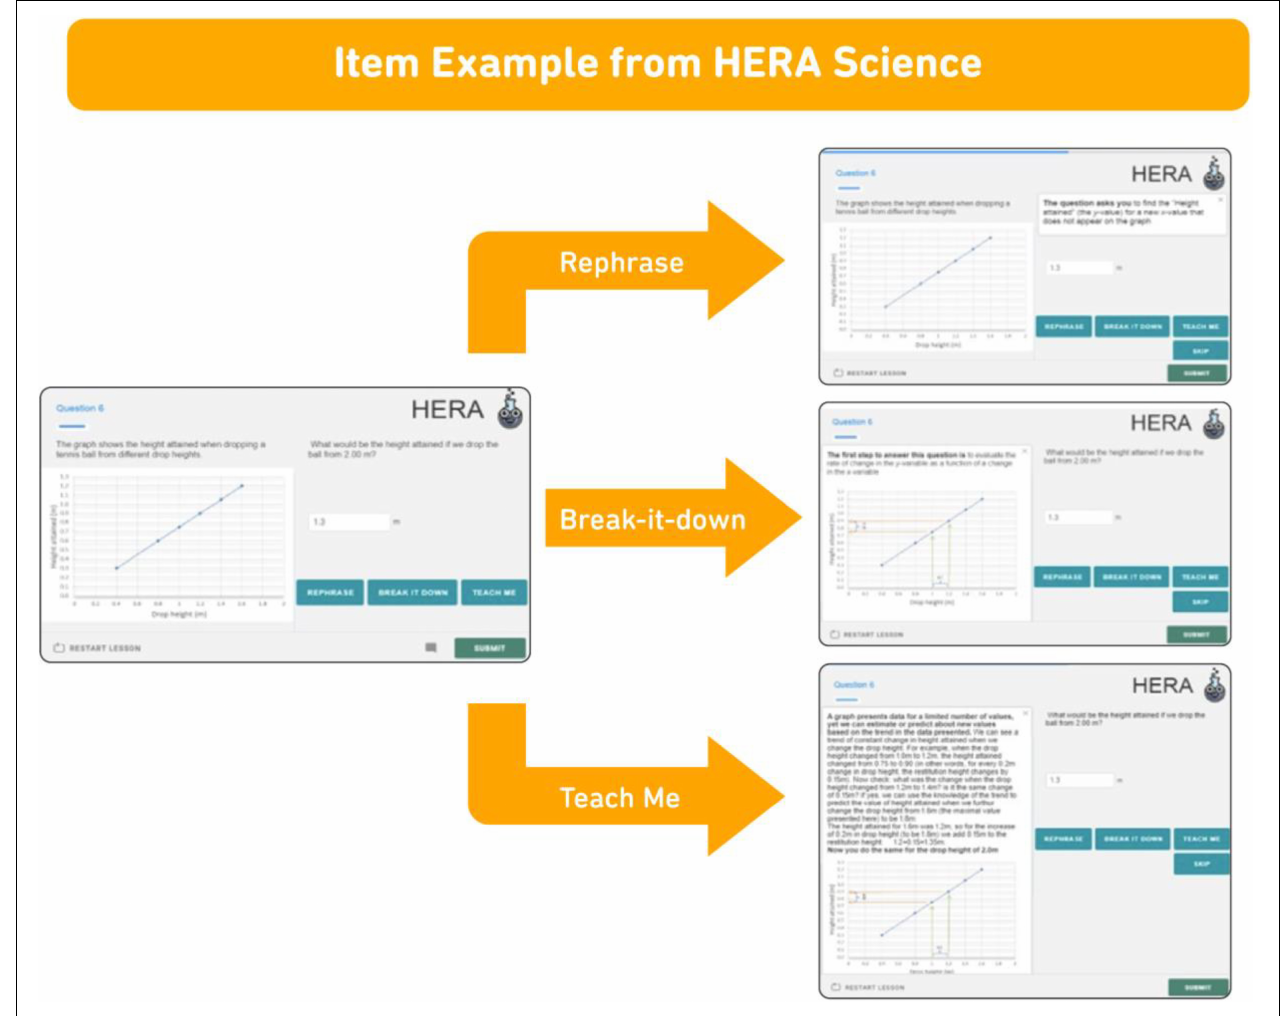
FIGURE 3 | Sample item from HERA Science with the three adaptive learning scaffolds to assist students. Reprinted with permission from ACT,